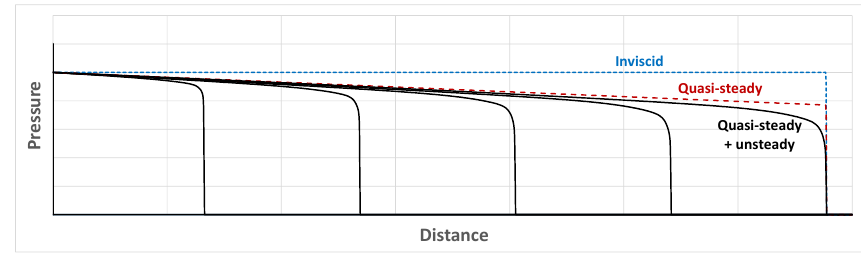
Figure 1. Influence of skin friction on a compressive wavefront in pipe flow.